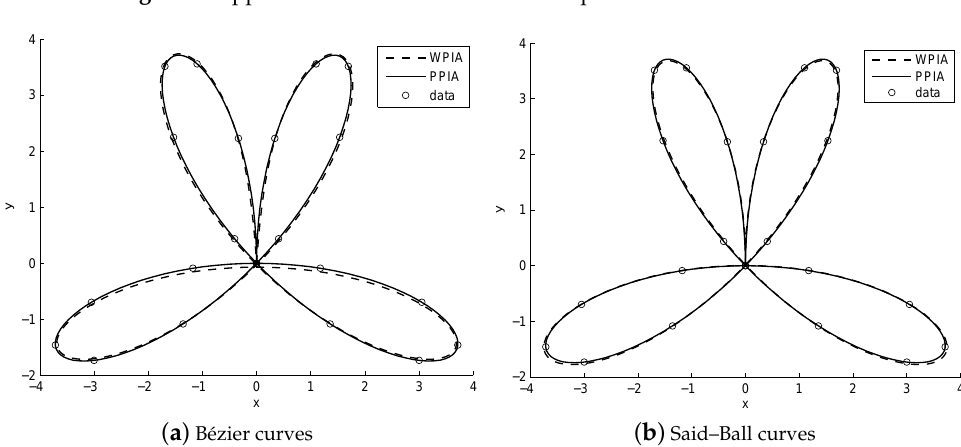
Figure 5. Approximations of the helix in Example 2 at the tenth iteration.